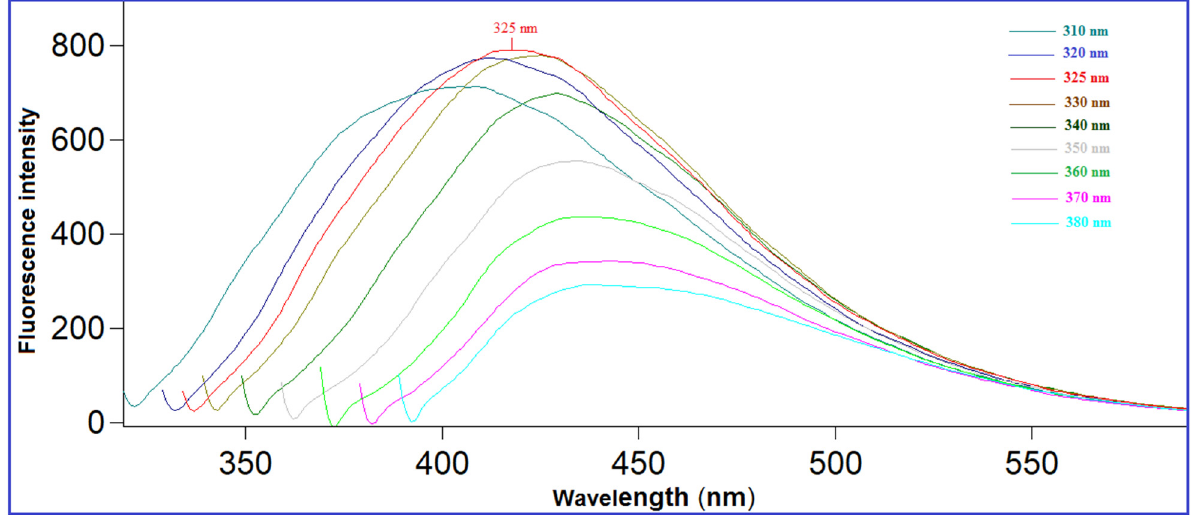
Figure 2. Fluorescence spectra of N-CQDs at varied excitation wavelengths (310–380 nm).